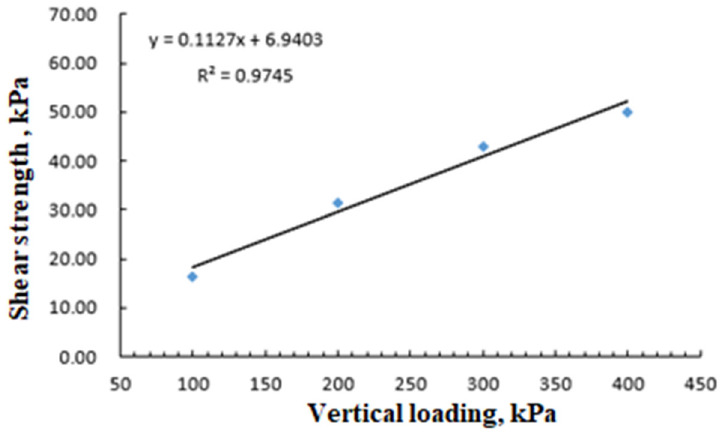
Figure 9. The relationship between the shear strength of the soil and the vertical loading.